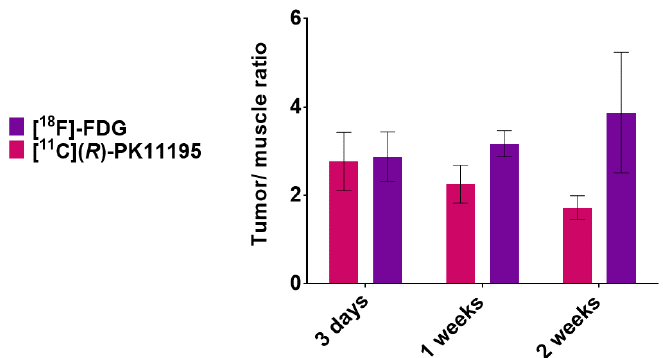
Figure 5. Tumor/muscle uptake ratio: the [ 11 C]( R )-PK11195 tumor/muscle uptake ratio at 3 days ( n = 4), 1 week ( n = 20), and 2 weeks ( n = 12), and the [ 18 F]FDG tumor/muscle uptake ratio at 3 days ( n = 5), 1 week ( n = 5), and 2 weeks ( n = 4), (Mann – Whitney U test).